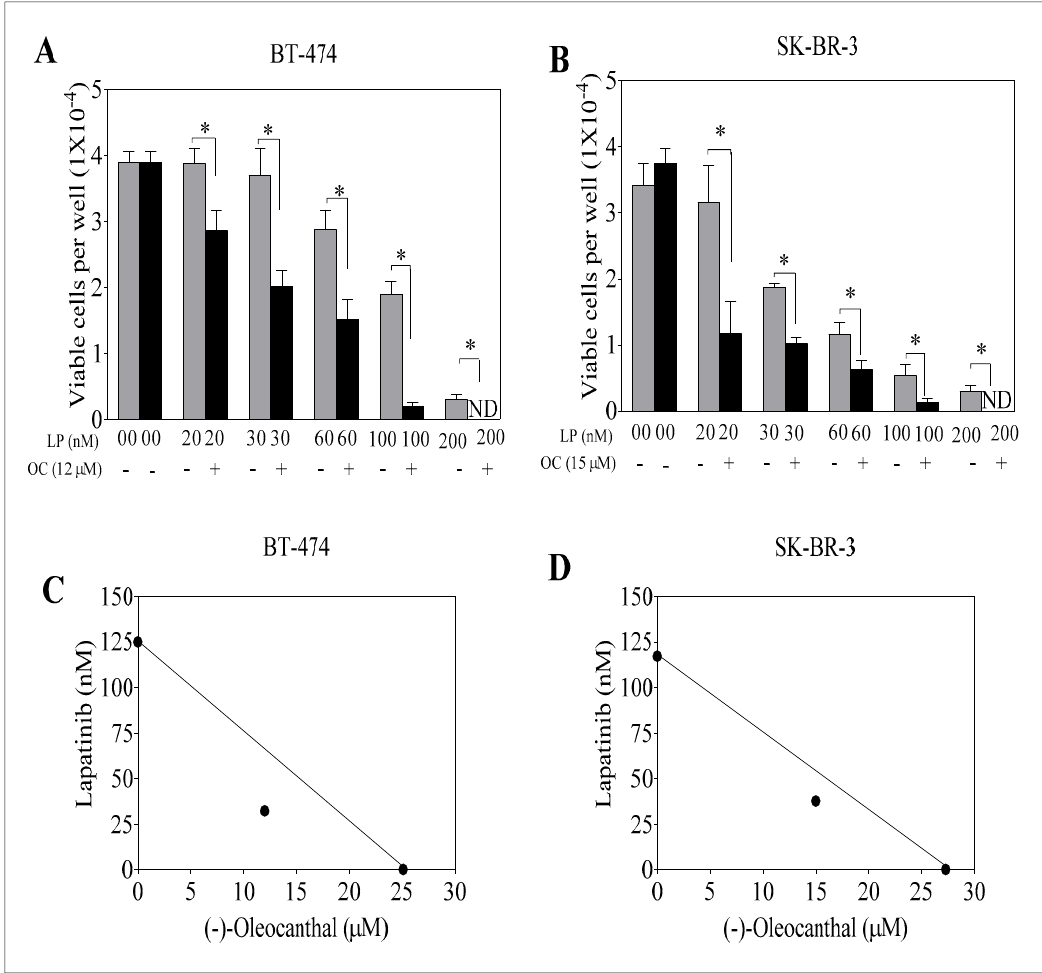
Figure 2. Effect of combined OC and LP treatments on growth of HER2-overexpressing BC cells. ( A ) Effect of sub-effective OC and LP combined treatment on BT-474 cells after 48 h culture period. ( B ) Effect of sub-effective OC and LP combined treatment on SK-BR-3 cells after 48 h culture period. Cells were plated at a density of 1 × 10 4 cells/well in 96-well plates and maintained in media supplemented with 10% FBS and allowed to adhere overnight. Next day, cells were treated with vehicle-control or sub- µ M dose of OC or nM dose of LP either alone or combined in serum-free media containing HGF and EGF 40 ng/mL as mitogens for 48 h. At the end of treatment, viable cell number determined by the MTT colorimetric assay. Vertical bars indicate the mean cell count ± SEM ( n = 6) in each treatment group. * p < 0.05 as compared with individual LP treatment. ( C , D ) Isobolograms of combined OC and LP anti-proliferative effect in BT-474 and SK-BR-3 cells, respectively. IC 50 concentrations for OC and LP plotted on the X - and Y -axis, respectively. The solid line connecting these points represents the concentration of each compound required to induce the same relative growth inhibition when used in combination if the interaction between the compounds is additive. The data point on each isobologram represents the actual concentrations of OC and LP, which induced 50% inhibition of cell growth when used in combination. ND; not detectable.